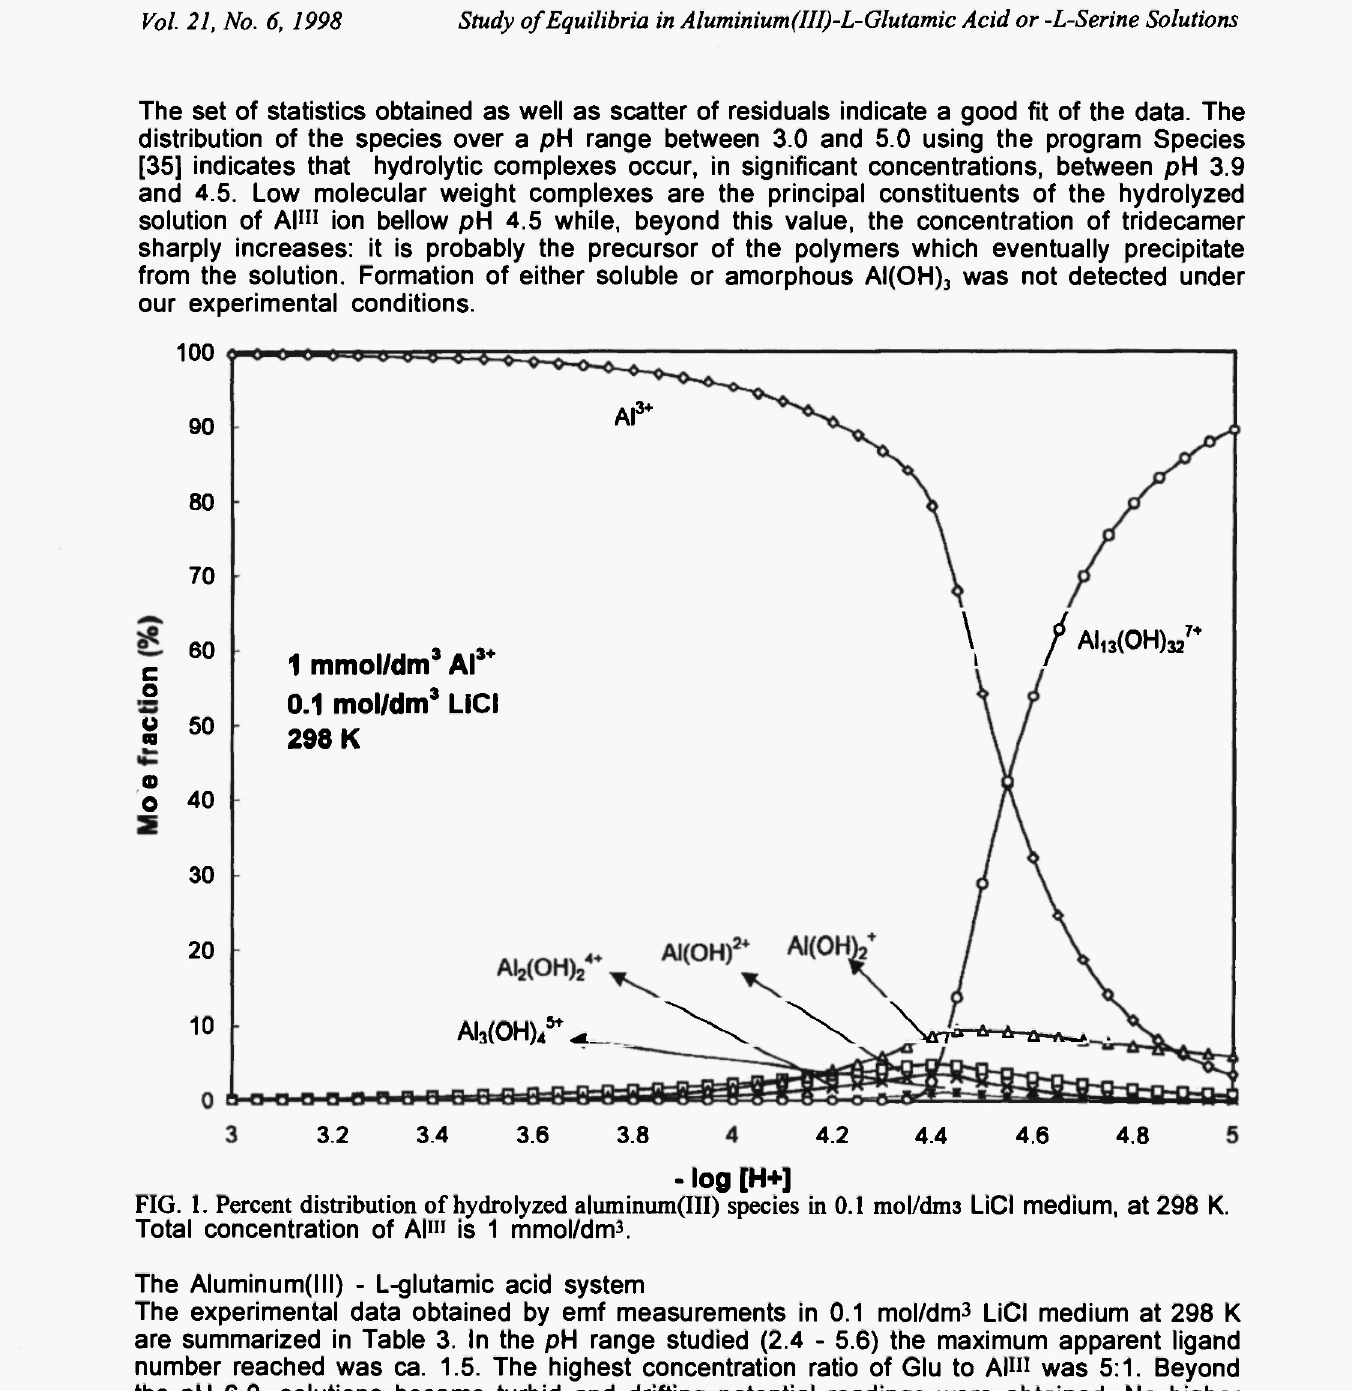
FIG. 1. Percent distribution of hydrolyzed aluminum(III) species in 0.1 mol /dm3 LiCI medium, at 298 K. Total concentration of Al>" is 1 mmol/dm 3 . The Aluminum(lll) - L-glutamic acid